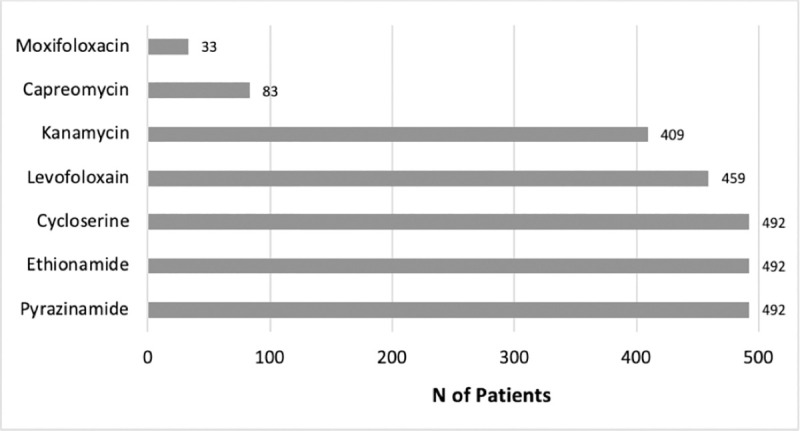
Longer regimen combination used for MDR-TB patients.MDR-TB: Multidrug-resistant TB, N: Number.